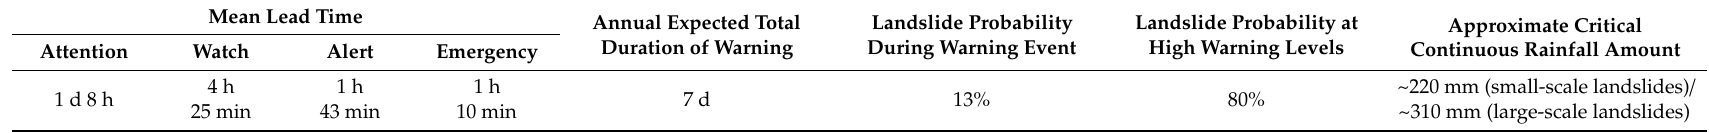
Table 5. Summary of temporal performance of the landslide early warning system based on the sequential evaluation method in the specific case study